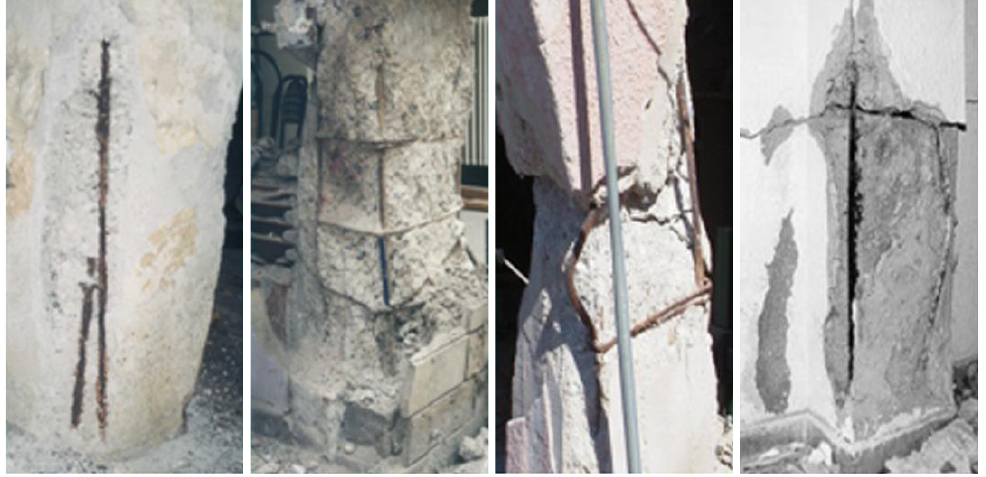
Figure 2. Corrosion of RC members damaged during the 1999 Izmit Earthquake in Turkey.